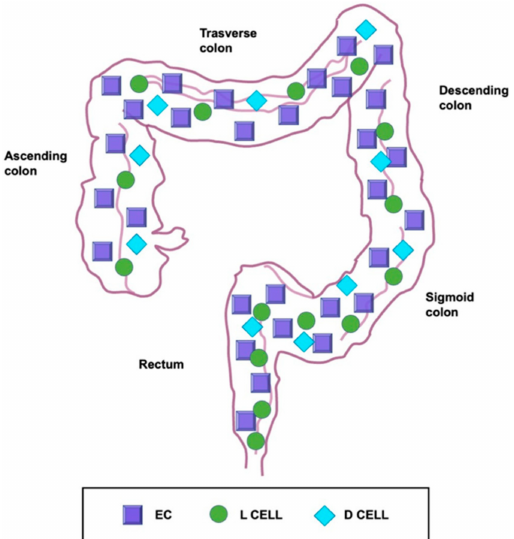
Figure 5. Schematic representation of the different cells that could differentiate from the intestinal stem cells. They could present an absorptive pattern or a secretory activity, including enteroendocrine cells, Paneth cells, and goblet cells. EC: enterochromaffin cell; black arrows and black dotted arrows represent the differentiation process from staminal to intestinal specific cells. The Figure is obtained from Beumer et al., 2020. Reprinted under the terms of the Creative Commons CC BY license [3]. ECs are the most abundant EECs in the GI tract and are distributed widely in the gastric antrum, in the small and large intestine [23] (Figure 6). Giver their abundant distribution, we decided to summarize the discovery, localization, and the role of these cells in the GI tract.